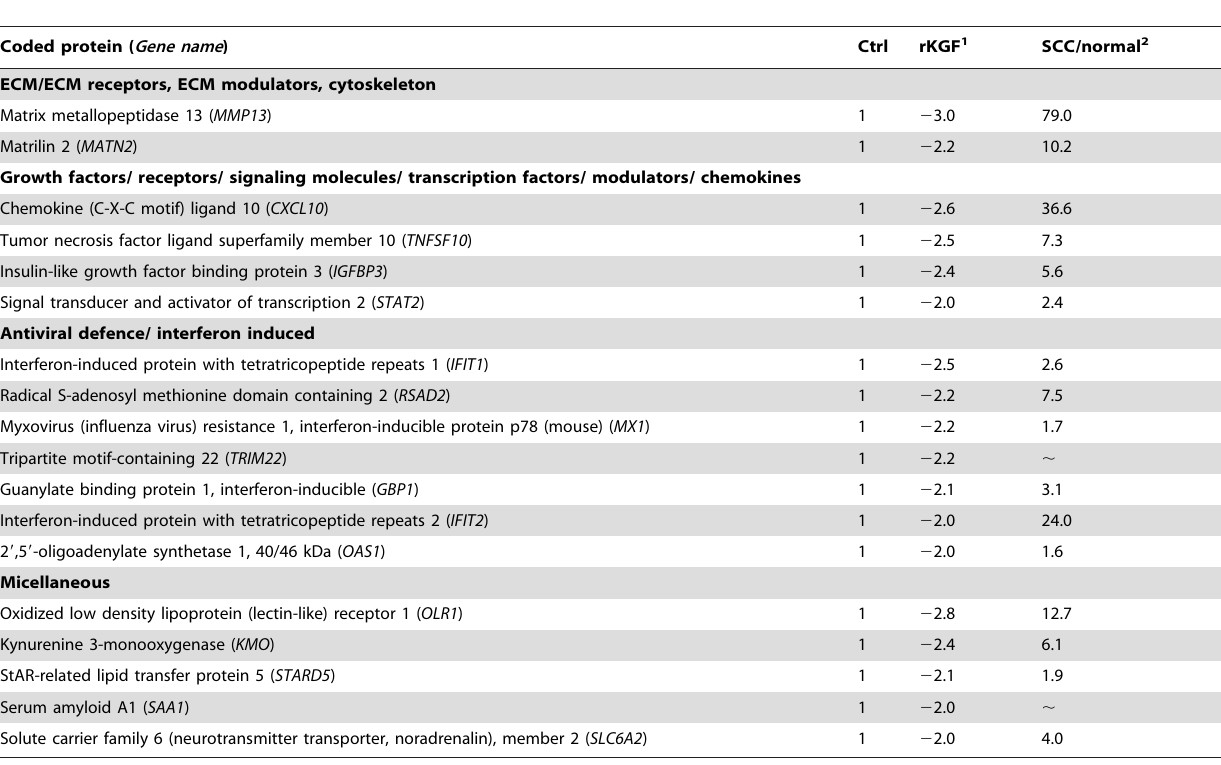
Table 2. Downregulation of different classes of genes in cutaneous SCC cells by KGF as determined by DNA microarray analysis.